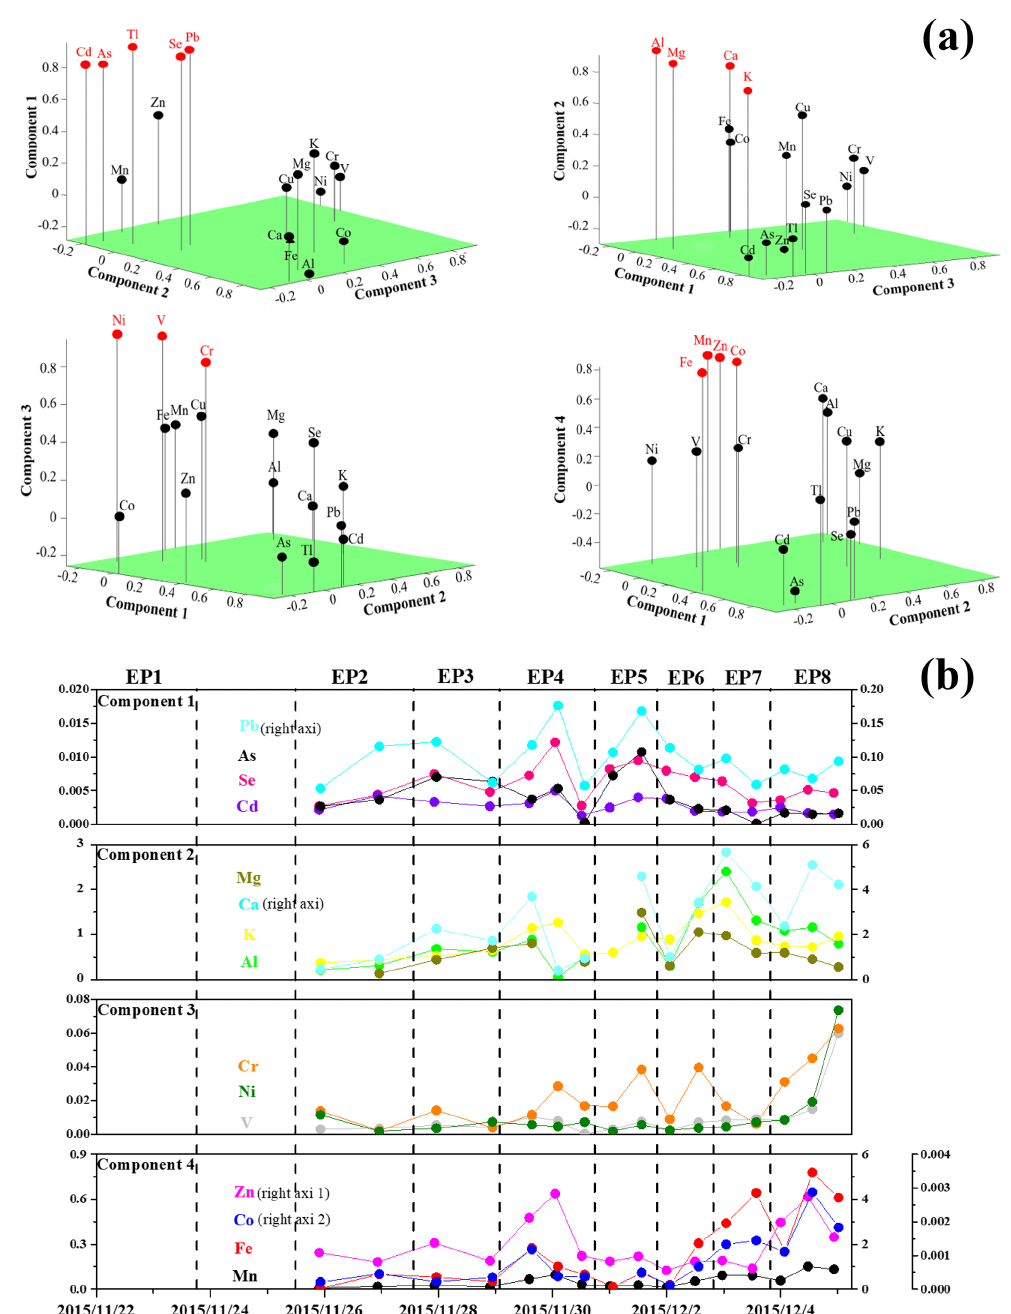
Figure 5. (a) Principal component analysis (PCA) of the typical elements in PM 2 . 5 ; (b) time series of four typical element sources derived from PCA. All of the units are in micrograms per cubic